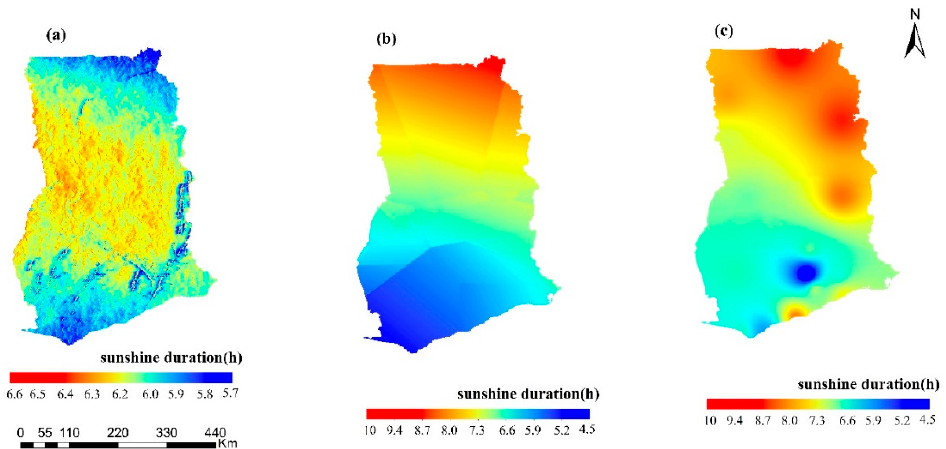
Figure 3. Comparison of SD obtained for 2010 ( a ) over complex terrain and using ( b ) IDW and ( c ) kriging.